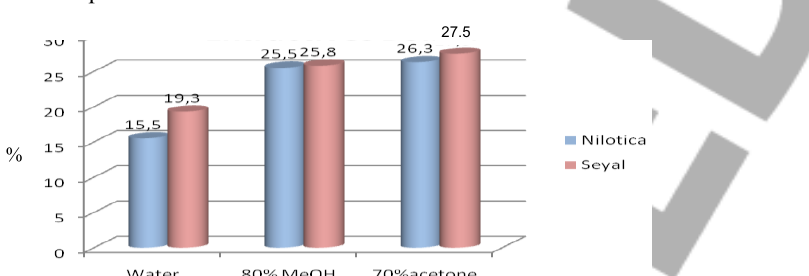
Figure 1 . Effect of extraction solvents (Boiled) on the part of species of Acacia.